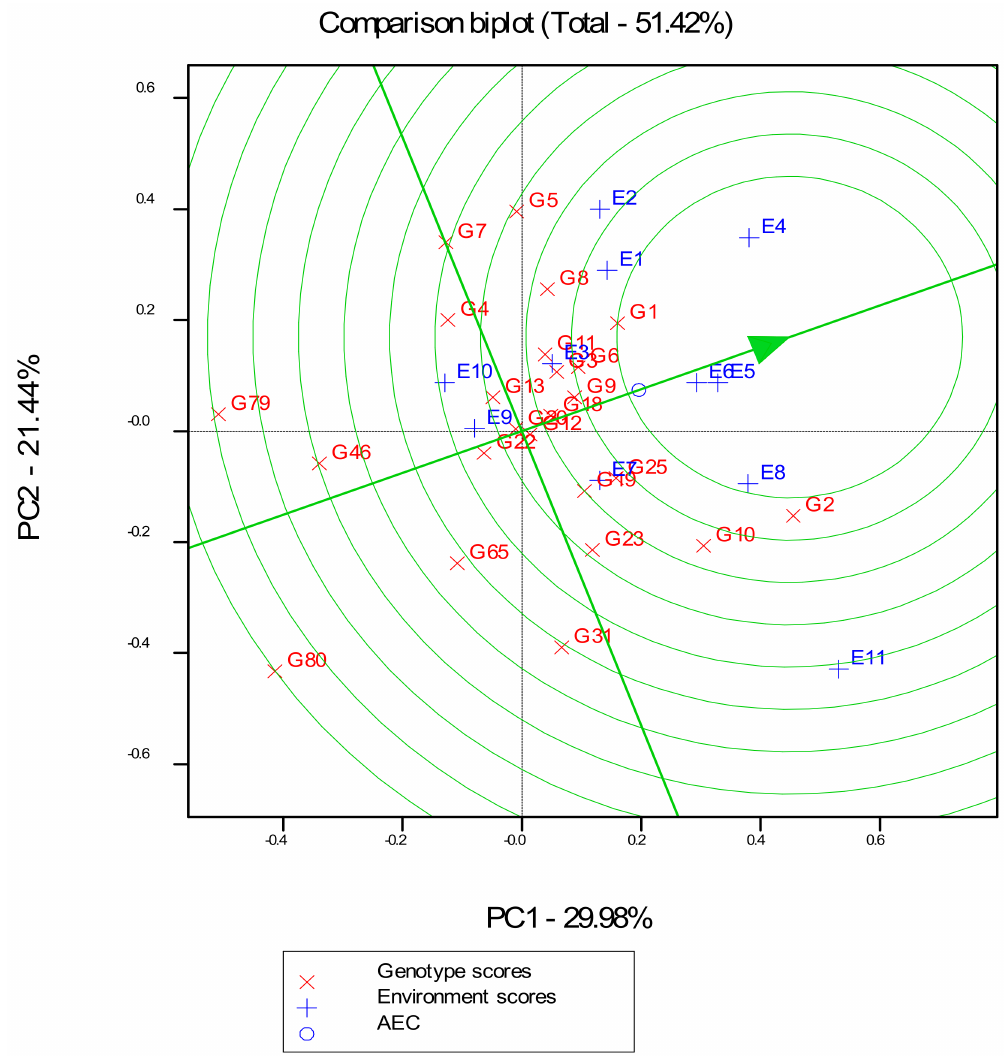
Figure 4. Comparison view of 24 hybrids with the ideal genotype based on average grain yield and stability for grain yield across 11 environments in 2012 and